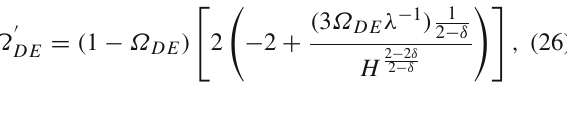
The f ( a ) plot in this case shows the Λ CDM profile to predict significantlyhigher growthratethantheTHDE model prior a specific scale factor dependent solely on the non- additivity parameter δ following which the growth rate in the THDE model exceeds the one for the Λ CDM. For δ = 1, the profile intersects the Λ CDM at a (cid:7) 0 . 52 and at a (cid:7) 0 . 81, for δ = 1 . 02,thecrossingoccursat a (cid:7) 0 . 44and a (cid:7) 0 .